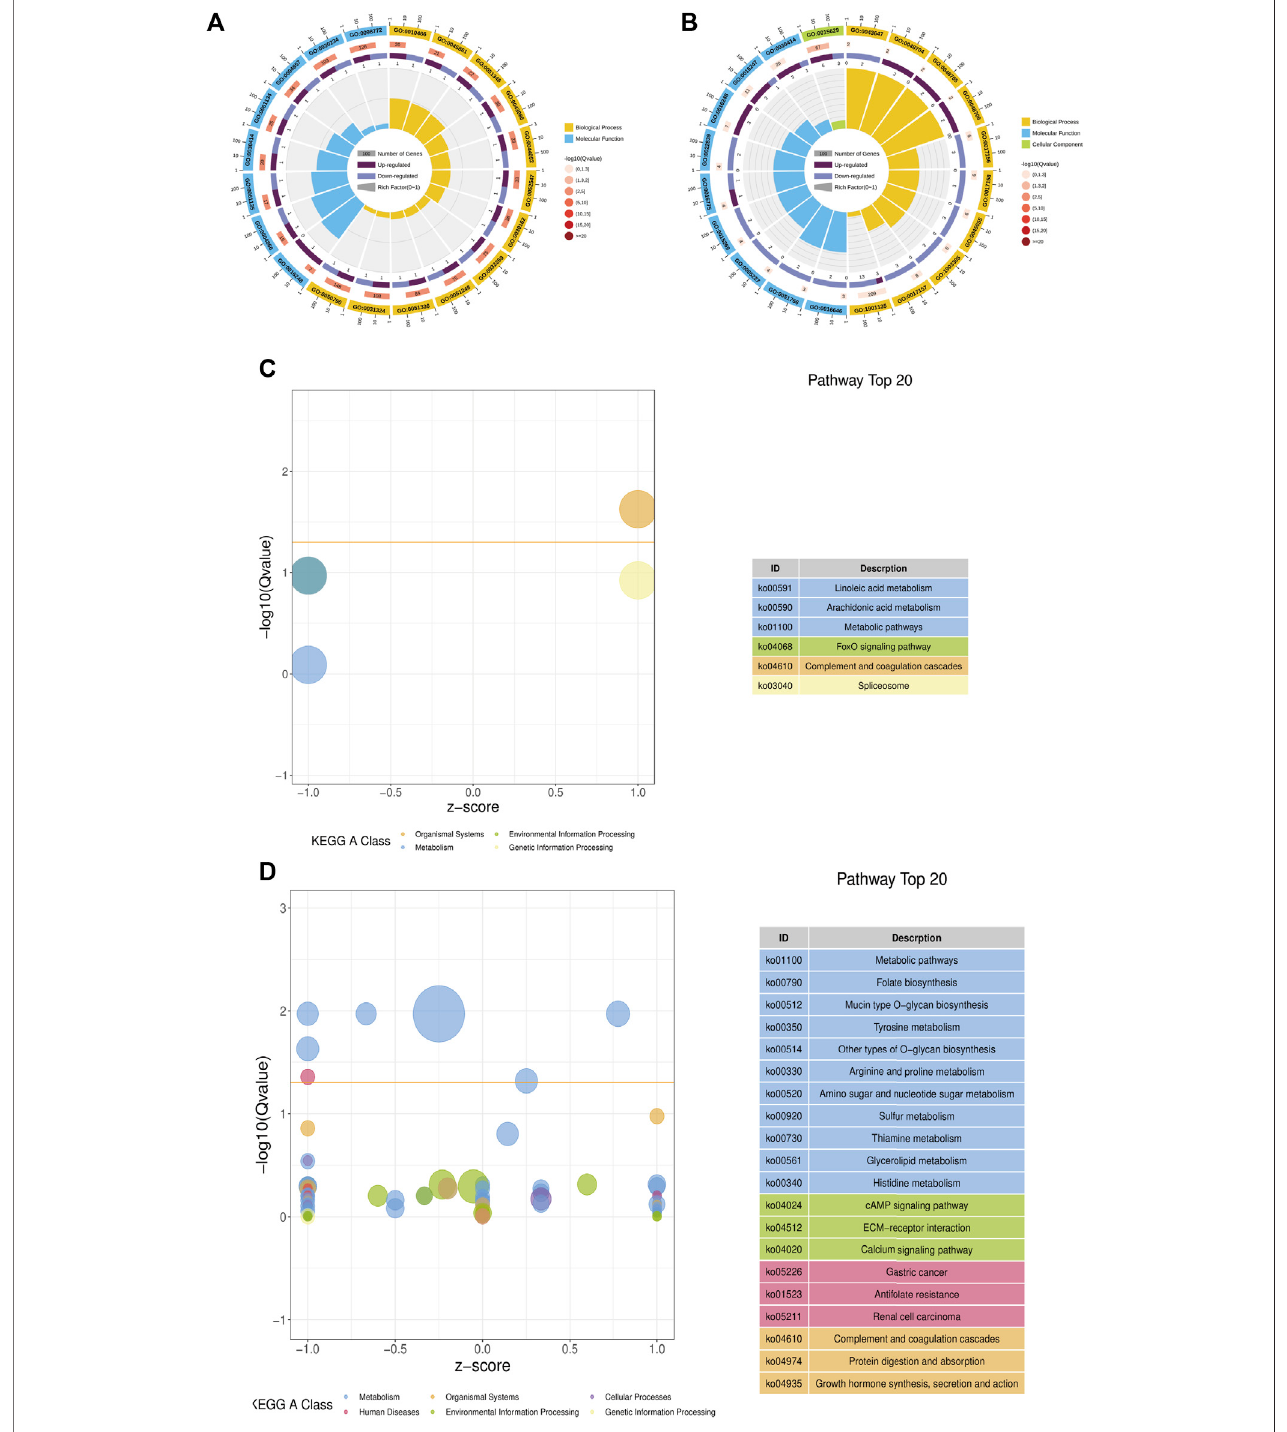
FIGURE5| GOandKEGG functionenrich inDEGs. (A) Statisticsofthetop20GOtermsenriched forDEGsinYMP vs.WMP; (B) statistics ofthetop 20GOterms enriched for DEGs in YMP vs. YMC; (C) statistics of the pathways enriched for DEGs in YMP vs. WMP; (D) statistics of the top 20 pathways enriched for DEGs in YMP vs.